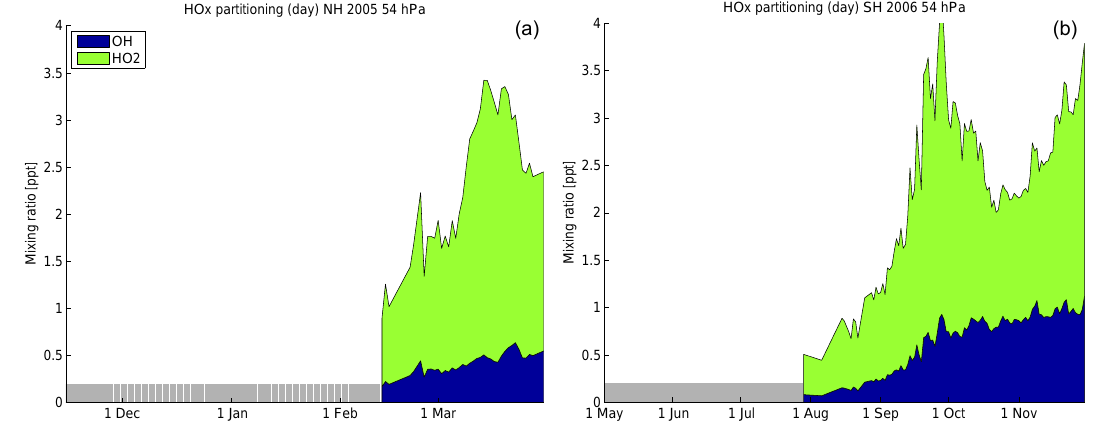
Figure 9. Vortex-averaged partitioning of HO x species for the Arctic winter 2004–2005 (a) and the Antarctic winter 2006 (b) at 54hPa. The plots show daytime averages (parts of the vortex where the solar zenith angle is smaller than 80 ◦ ). Nighttime averages are near zero and not shown. Days without sufficient data for averaging are not shown (grey bars).